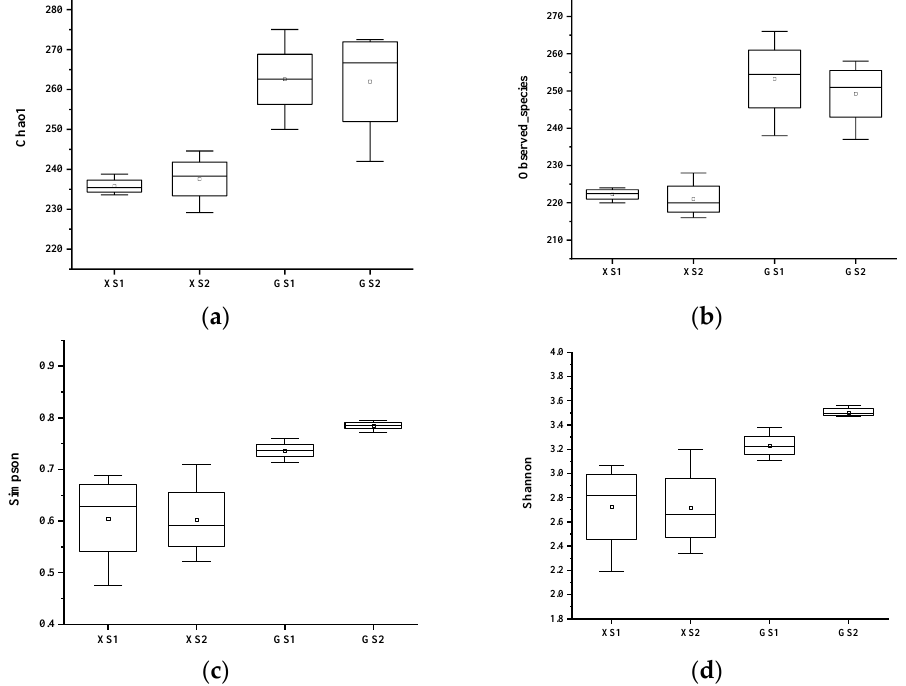
Figure 7. Analysis of bacterial abundance and diversity index of two sourdough fermentation periods. (( a ) represents the changing trend of the Chao1 index; ( b ) represents the observed species change trend; ( c ) represents the Simpson index variation trend; ( d ) represents the variation trend of the Shannon index).